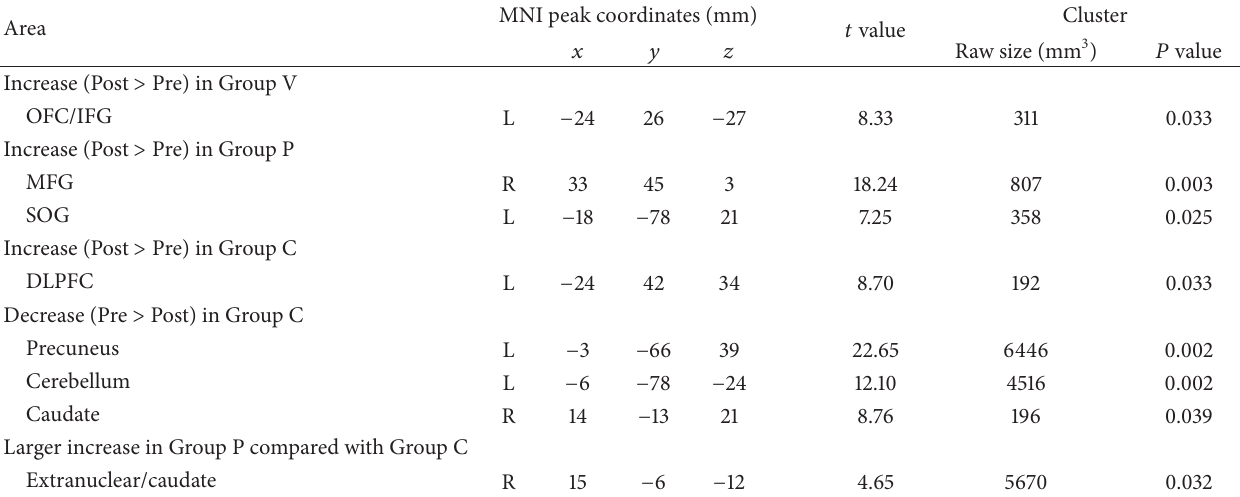
Table 5: Summary of regional gray matter volume changes detected by the voxel-based morphometry analysis.